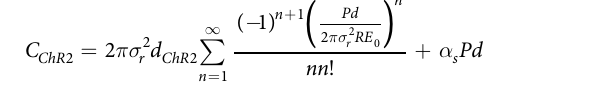
with P being the laser power, d the pulse duration and 2 σ r the beam waist. Eq. 1 was used to fit the experimental data (MSE < 10 − 4 ) for various pulse durations (Fig. 3c) yielding the following parameters RE 0 of 79 ± 18 pJ μ m − 2